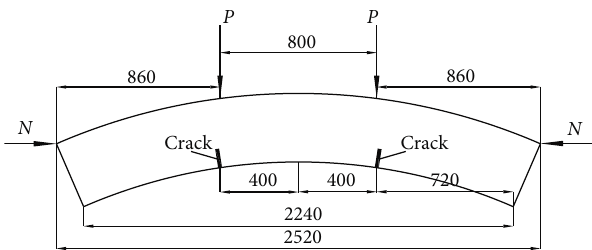
Figure 3: Sketch of the defective shield segment (unit: mm).